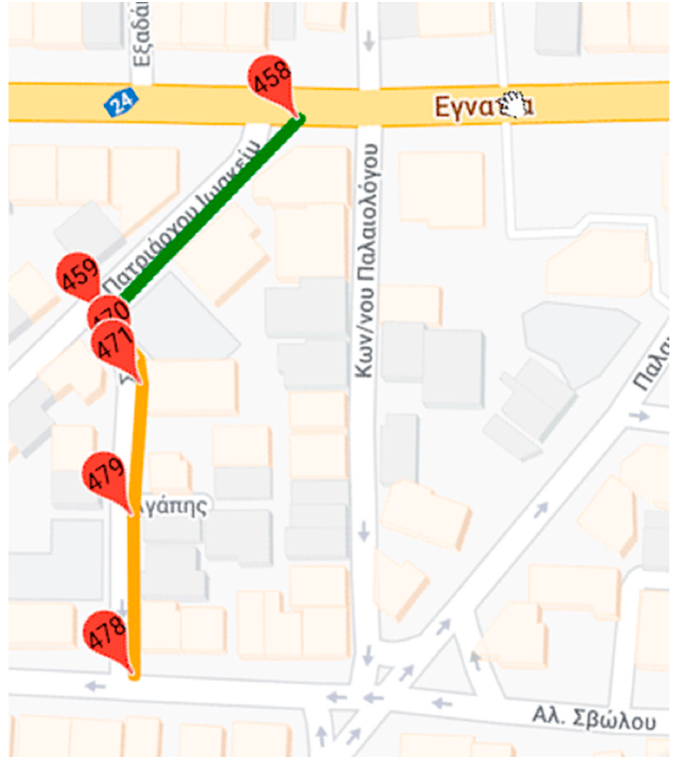
Figure 10. Shortest path between nodes 458 and 478 and the most accessible path between them using 1st version of the algorithm. Table 4. k-shortest paths for use case IV.